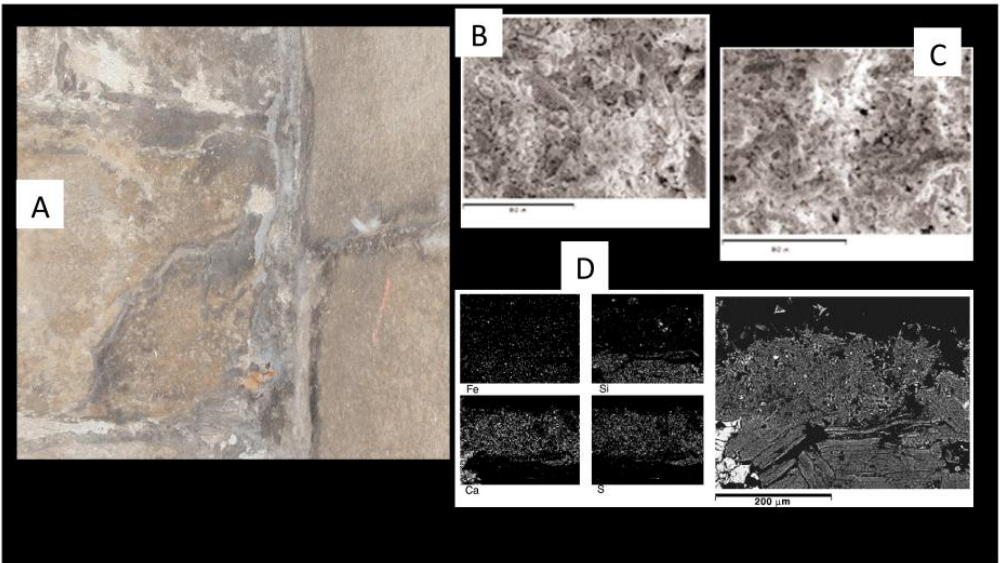
Figure 5. Covering layer on the façade of the Colegiata de Santa Maria del Campo (A Coruña). ( A ) Detail of the area on the wall where the covering layer was taken, ( B , C ) SEM pictures of the covering layer surface, and ( D ) cross-section and X-ray map of the covering